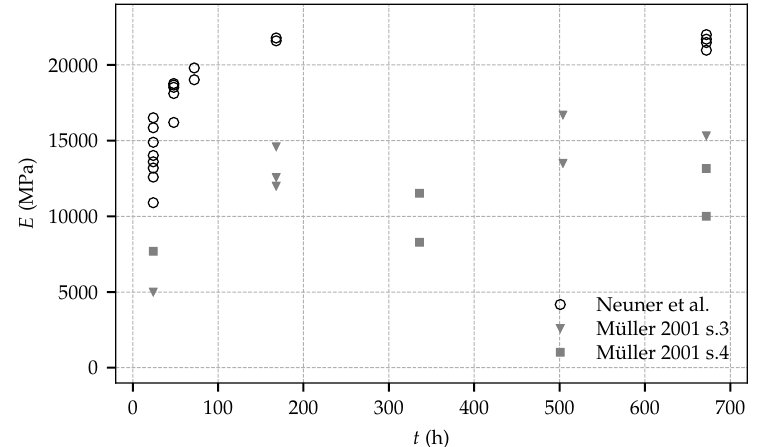
Figure 3. Evolution of the Young’s modulus: experimental results from the present experimental program and test data by